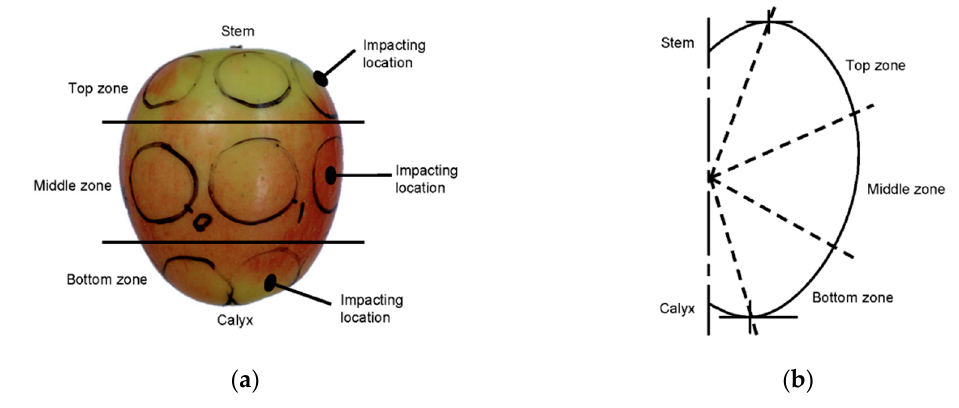
Figure 2. (a) Three impact test zones and visible impact locations within each zone on the surface of a stationary apple specimen; (b) A fruit section schematic depicting the three impact zones in an apple.